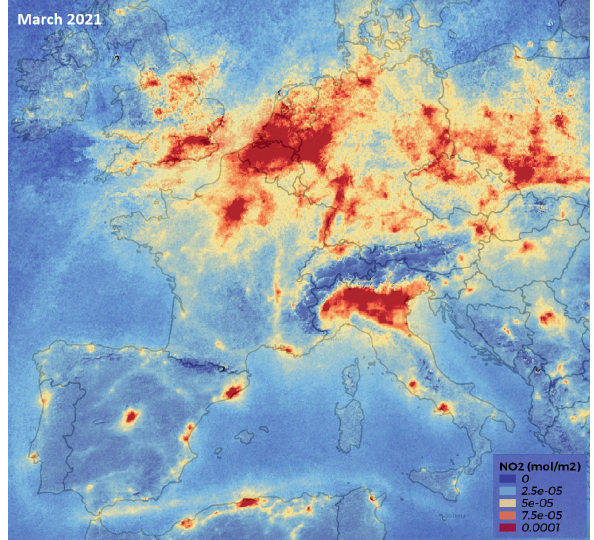
Figure 1. NO 2 levels in Europe in March 2021. ©DEFIS EU control and management methods, at a lower cost. There